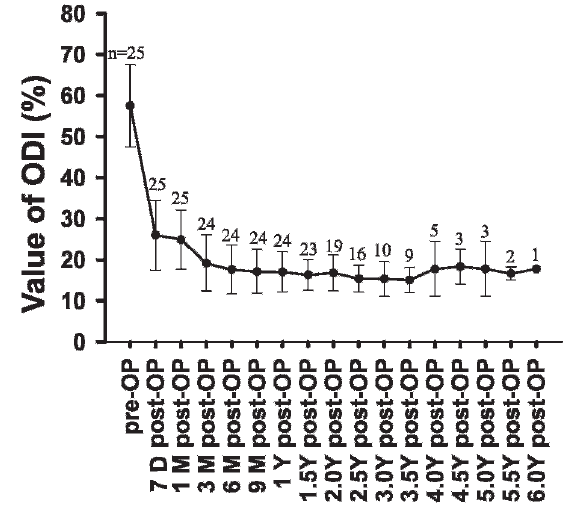
Figure 3 - The Oswestry disability index curve from pre- operation to six years post-operation. The number of patients is labeled on